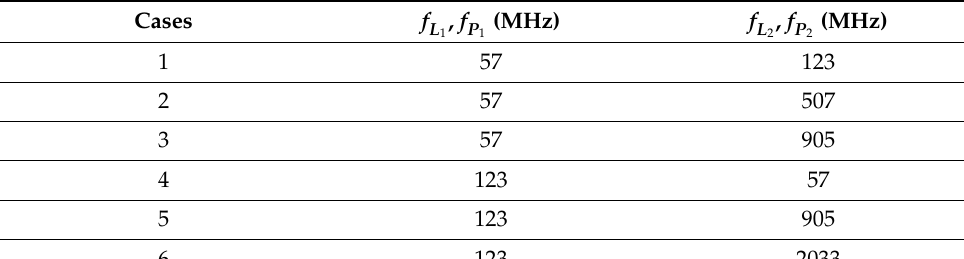
Table 8. Last stage and pre-driver: frequency settings of Figures 14 and 15.